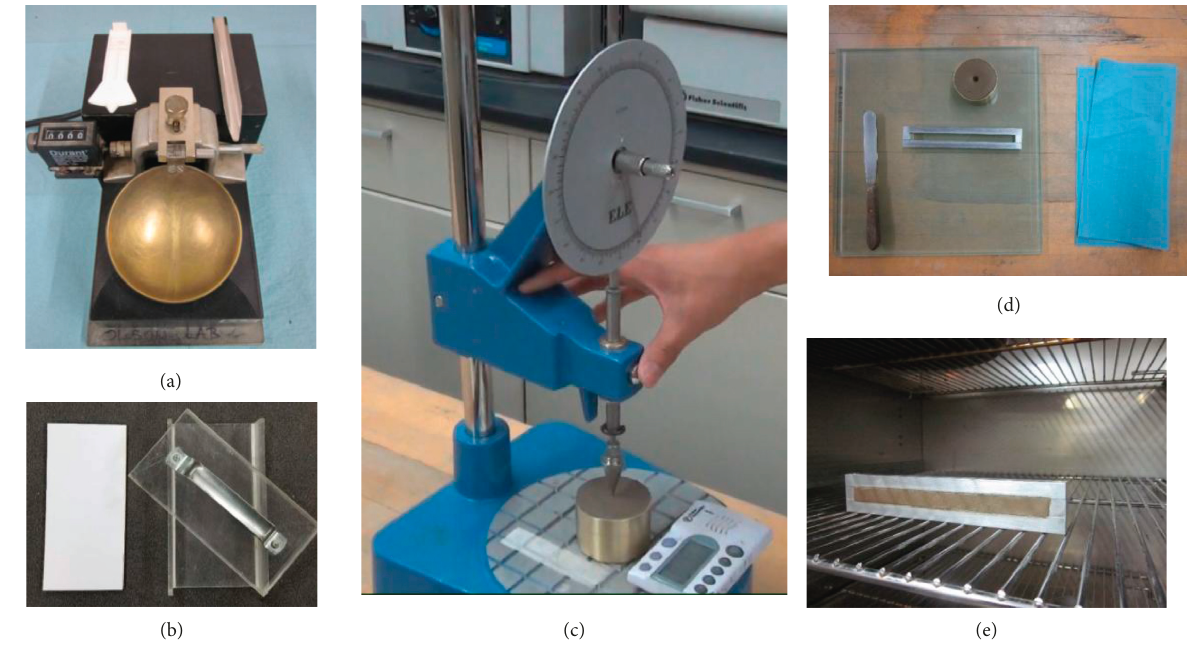
Figure 3: Test devices used in this study: (a) Casagrande LL test device, (b) PL rolling device, (c) fall cone test device, (d) BLS mold, and (e) BLS test specimen in the oven.